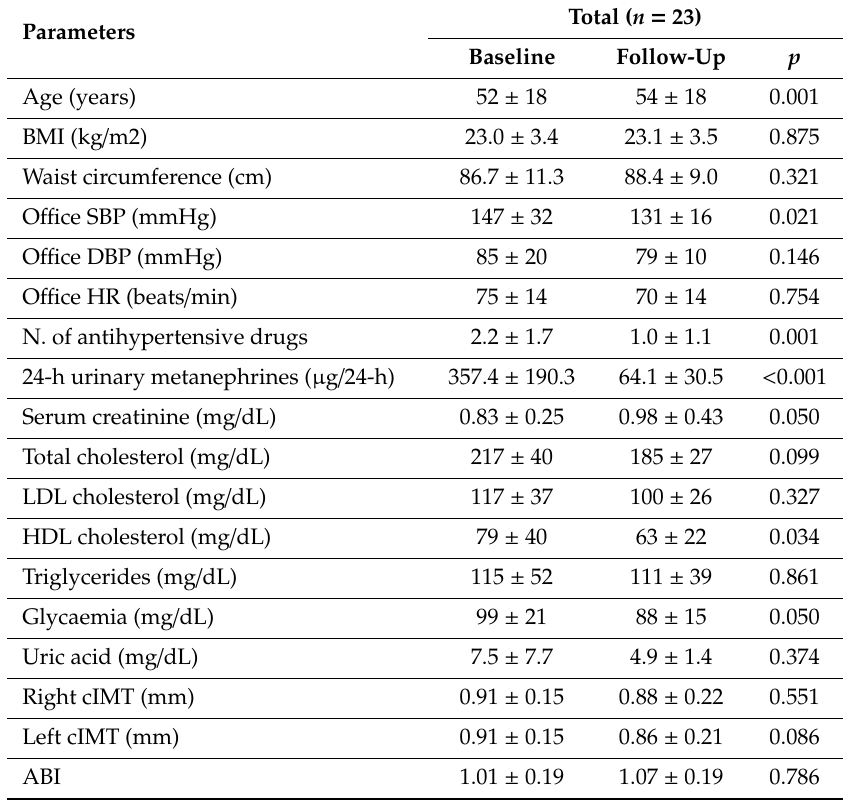
Table 2. Anthropometric, biochemical, and instrumental data at baseline compared to follow-up. Parameters